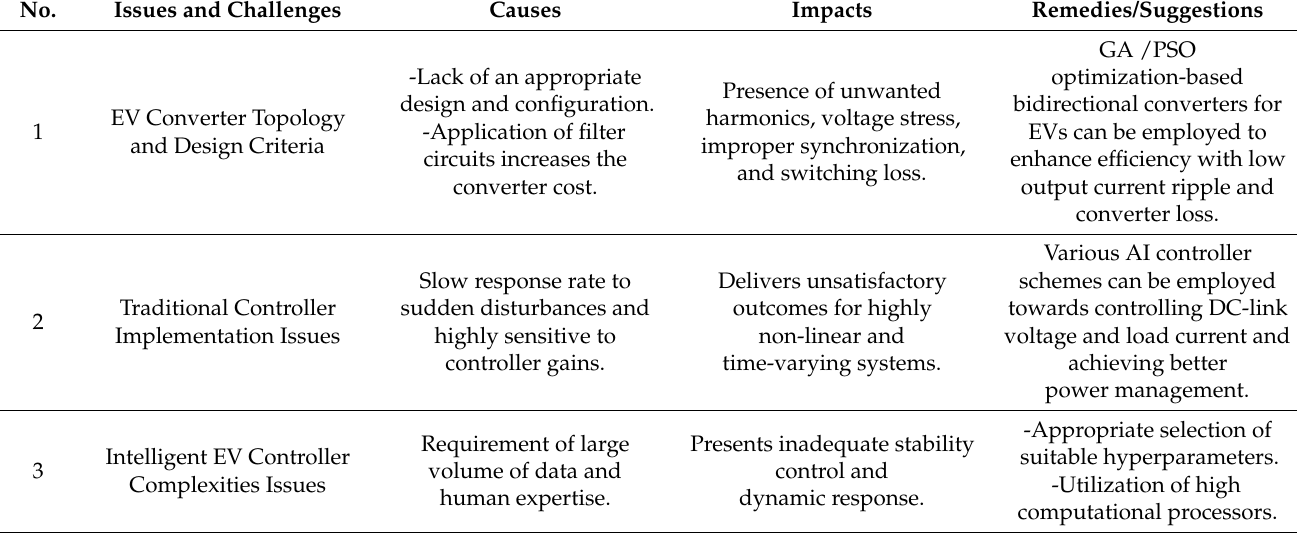
Table 11. Key challenges and possible solutions of EV converter